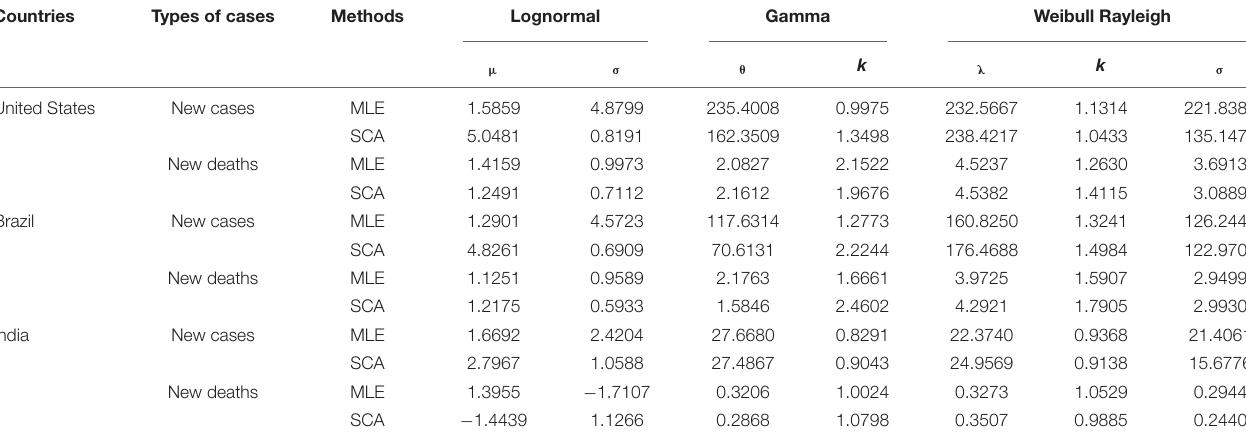
TABLE 3 | The parameters values of the different distribution functions are determined by MLE and SCA. Countries